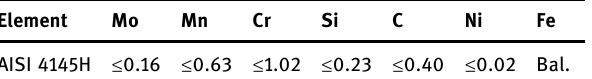
Element Mo Mn Cr Si C Ni